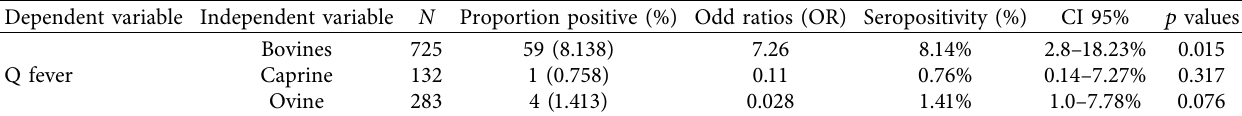
Table 4: Multivariate logistic regression model on Q fever and animal